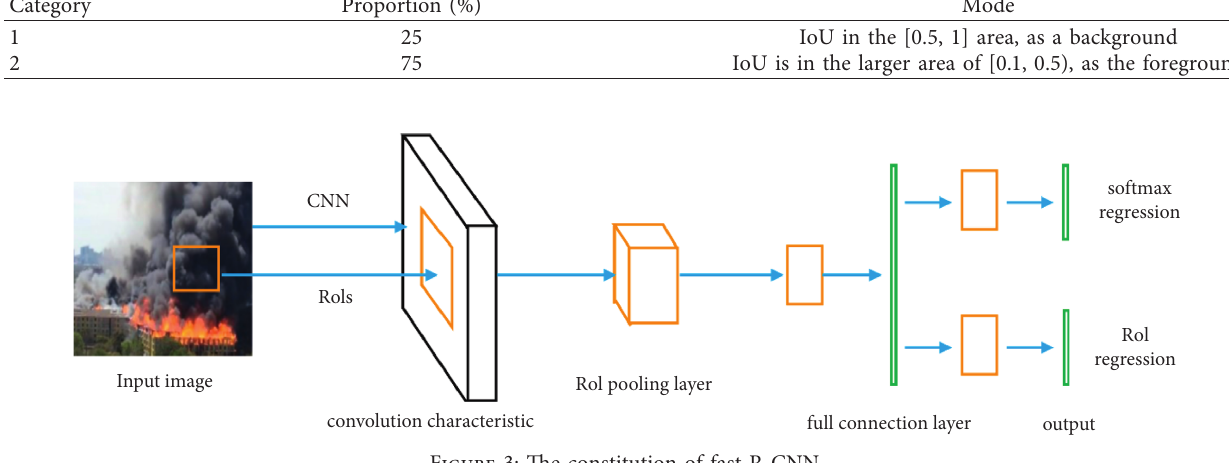
Figure 3: The constitution of fast